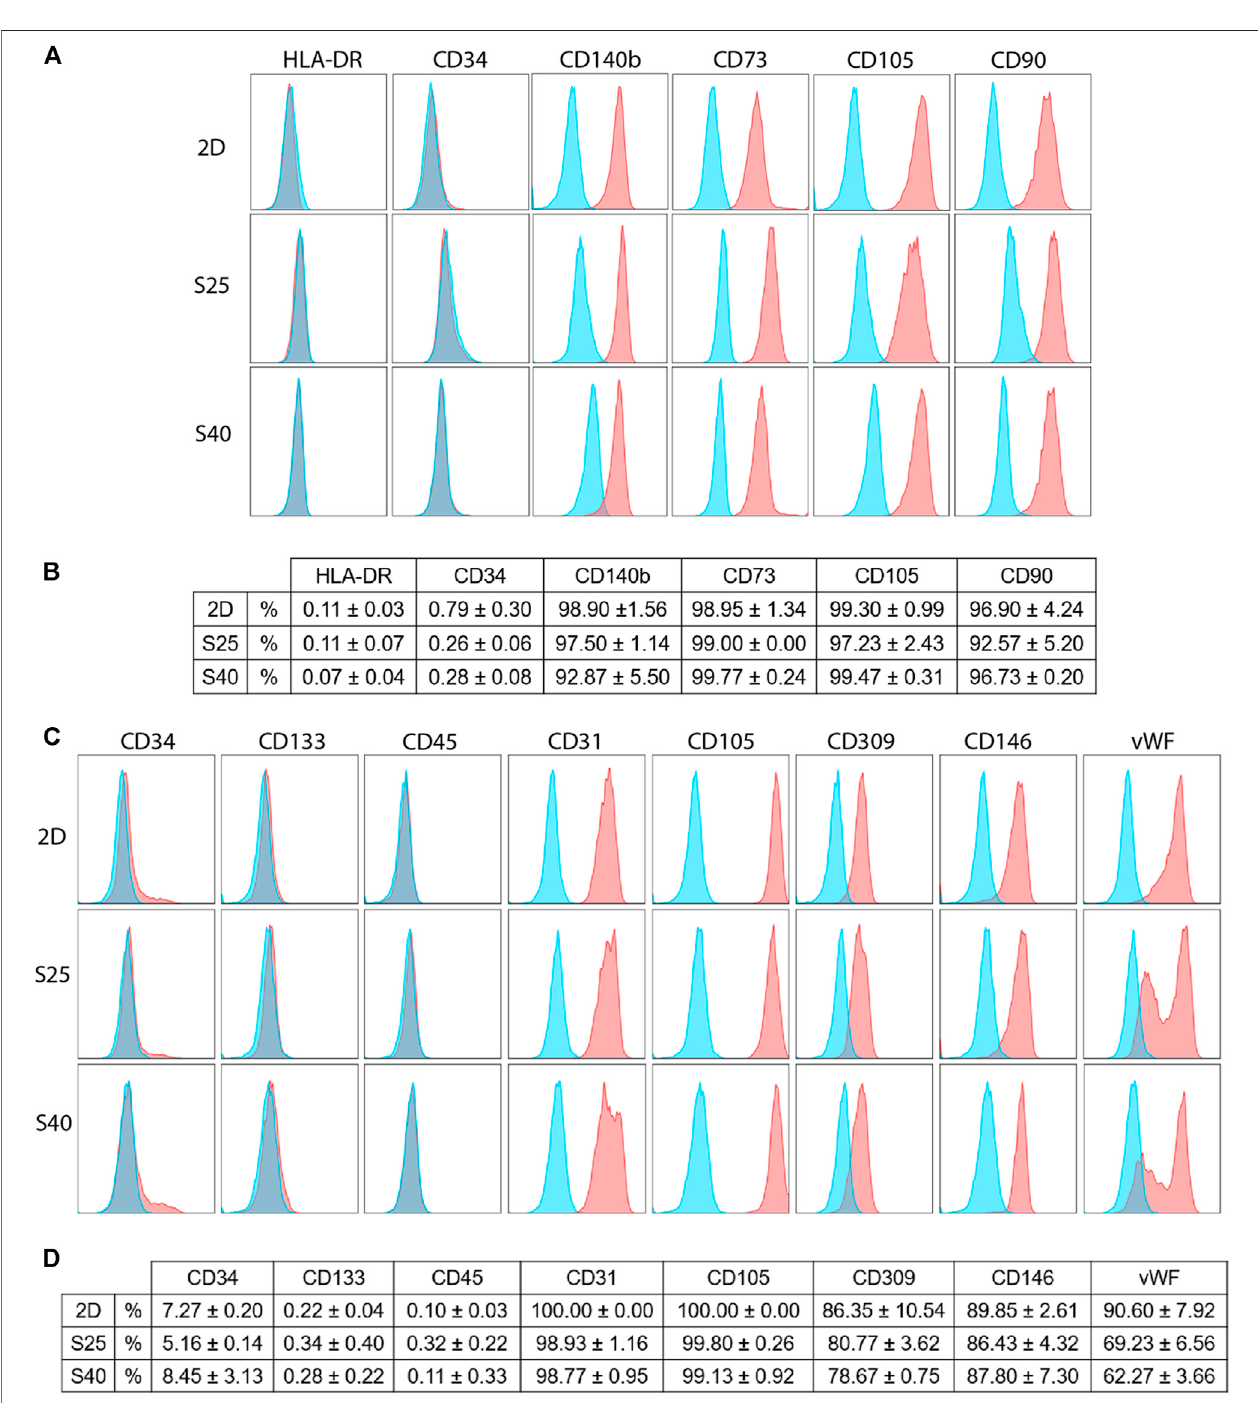
FIGURE 6 | Immunophenotypic pro fi le of the expanded CD133+ cells and the hASCs after 7 days of culture on the scaffolds in comparison to a 2D culture (A) Representative histograms of the hASCs immunophenotypic pro fi le when cultured on a 2D culture fl ask and on the 3D scaffolds (B) hASCs immunophenotypic pro fi le represented in percentage values (mean ± SD) (2D n (cid:1) 2; S25 n (cid:1) 3; S40 n (cid:1) 3). For the 3D scaffolds n represents the number of groups comprising three scaffolds that was analyzed. One-way ANOVA analysis (C) Representative histograms of the expanded CD133 + cells ’ immunophenotypic pro fi le when cultured in a 2D culture fl askandonthe3Dscaffolds (D) ExpandedCD133 + cells ’ immunophenotypicpro fi lerepresentedinpercentage values(mean ± SD)(2D n (cid:1) 2;S25 n (cid:1) 3;S40 n (cid:1) 3).For the 3D scaffolds n represents the number of scaffolds analyzed. One-way ANOVA analysis. % (cid:1) percent of parental population considering live/singlet gated cells.